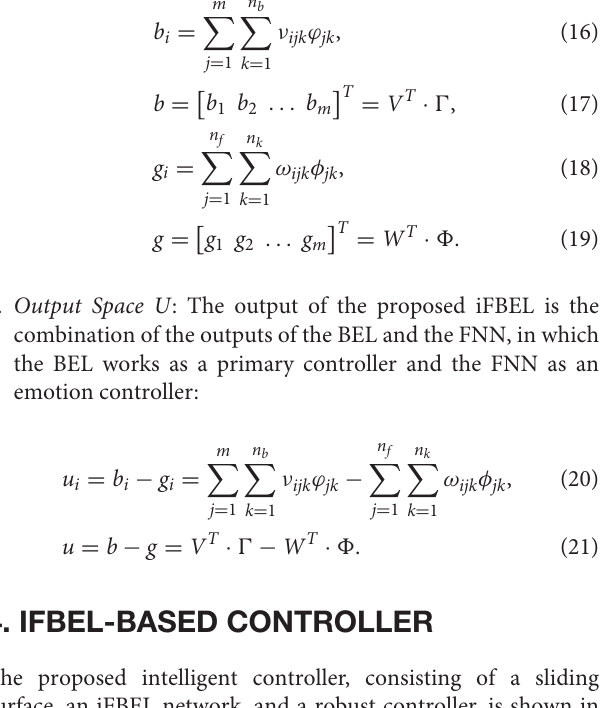
The proposed intelligent controller, consisting of a sliding surface, an iFBEL network, and a robust controller, is shown in Figure 3 . The iFBEL network and robust controller collaborate to imitate an ideal sliding mode controller. The updating rules of the BEL mechanism of the iFBEL network are followed by the brain emotional learning algorithm (Chung and Lin, 2015; Lin and Chung, 2015); and the adaptive laws of the FNN mechanism and robust controller are derived from the Lyapunov function. Besides, to ensure robust tracking